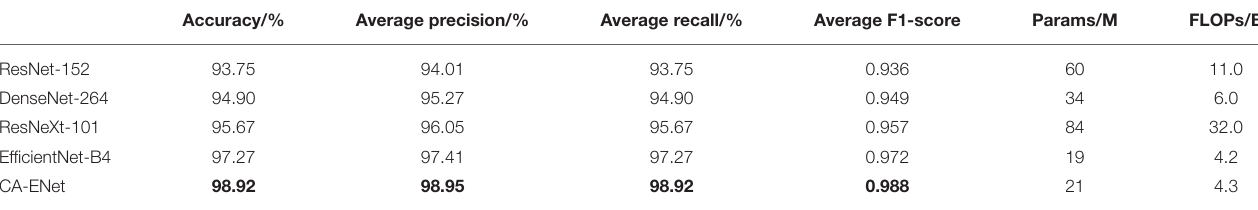
TABLE 3 | Performance comparison of the CA-ENet with other classical networks.